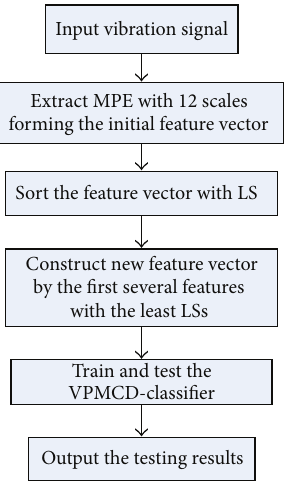
Figure 3: The MPE of Gaussian white noise signal with different embedding dimensions. Here 𝜏 max = 12 and 𝜆 = 1 .